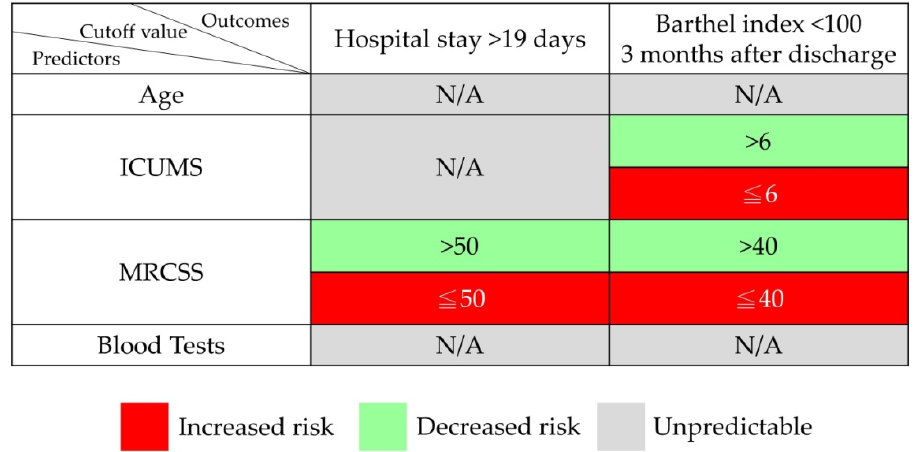
Figure 4. The predictive ability and the cutoff points for patients’ length of hospitalization > 19 days and Barthel index < 100 three months after discharge.